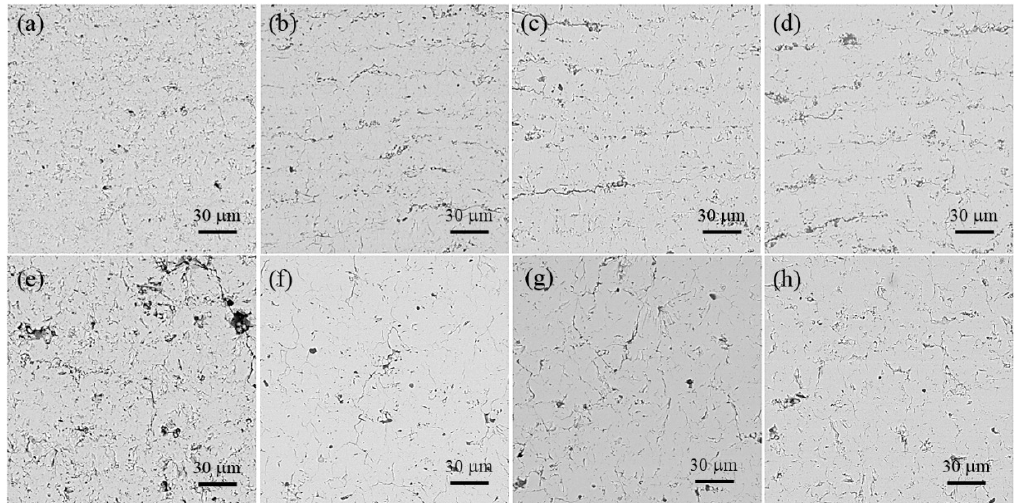
Figure 8. Pore structure of YSZ coatings deposited from two different size of powder after different thermal shock cycles: ( a ) As ‐ sprayed, 15–25 μ m; ( b ) after heat pre ‐ treatment, 15–25 μ m; ( c ) 20 cycles, 15–25 μ m; ( d ) 27 cycles, 15–25 μ m; ( e ) as ‐ sprayed, 45–60 μ m; ( f ) after heat pre ‐ treatment, 45–60 μ m; ( g ) 20 cycles, 45–60 μ m; and ( h ) 39 cycles, 45–60 μ m.